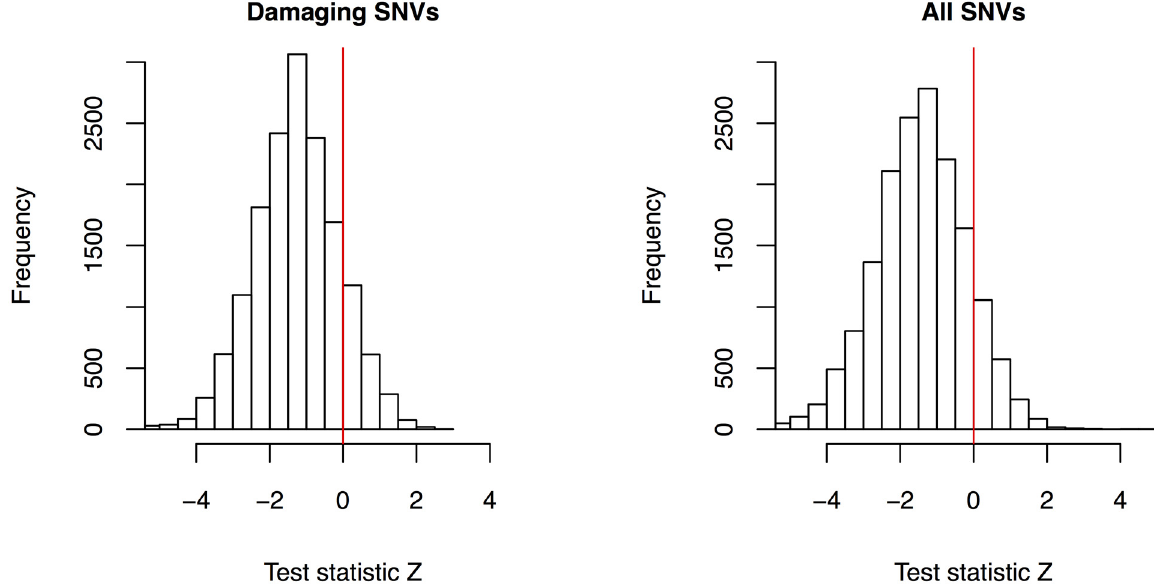
Fig 4. Distributions of the test statistic Z using damaging SNVs only (left side) and all SNVs (right side) in the analysis of the UK10K data. The left and right histograms are based on 15,659 and 16,318 genes, respectively.